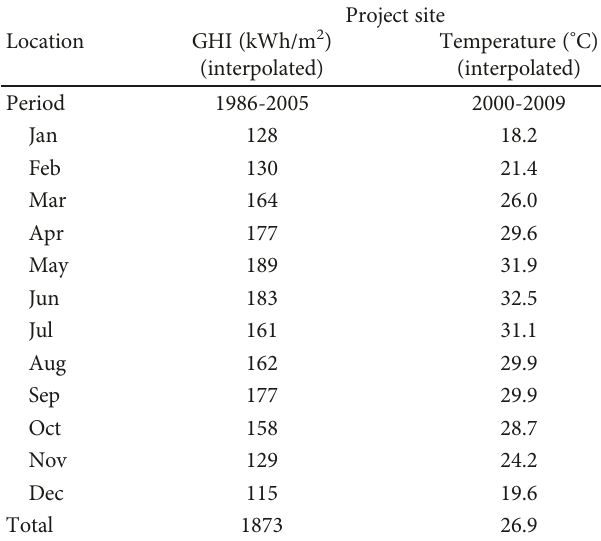
Table 5: Monthly values of GHI and temperature from Meteonorm from the project site.